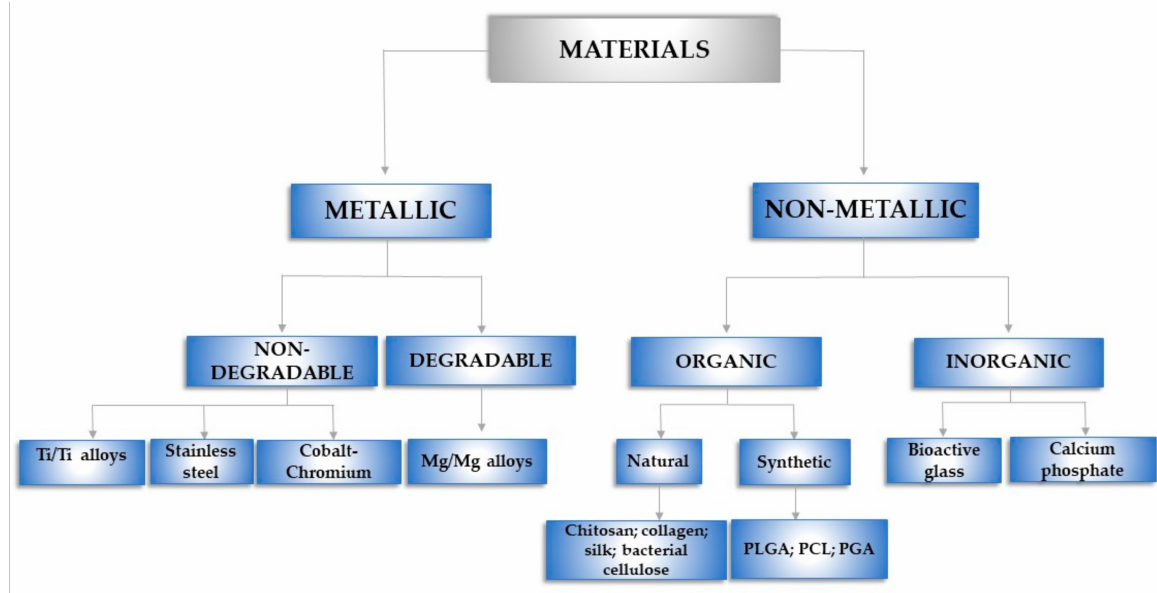
Figure 2. Various materials used in the bone tissue engineering field. PGLA: poly(lactic-co-glycolic acid); PCL: poly- ε - caprolactone; PGA: poly(glycolic